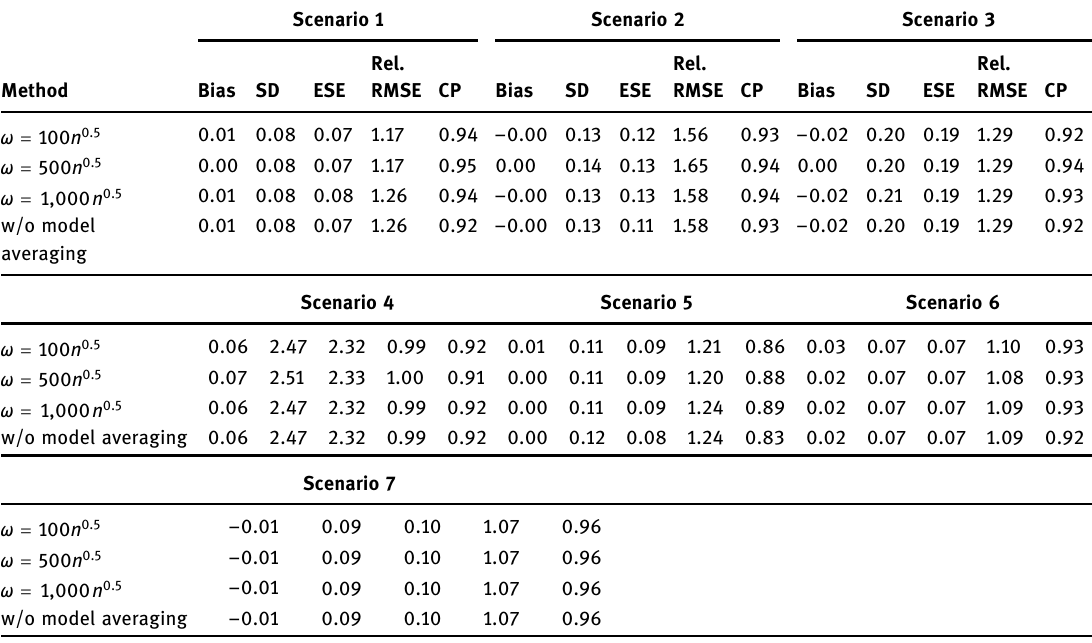
Table A12: Results of simulation Scenarios 1 – 7, with n